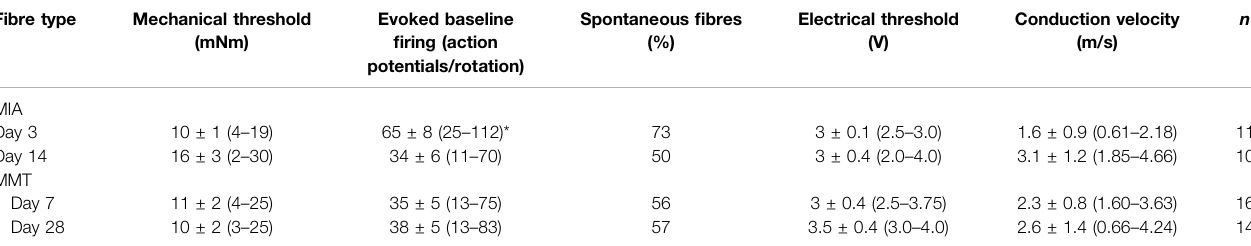
TABLE 2 | Electrophysiological characteristics of joint afferents from MIA and MMT animals. Fibres recorded from MIA and MMT animals during early and established OA were characterised based on baseline mechanical thresholds and evoked fi ring frequency, the presence spontaneous fi ring, electrical thresholds, and the calculated conduction velocity. * p < 0.05 denotes statistical signi fi cance comparing the two timepoints in each model using a Student ’ s t -test. Data presented as means ± SEM and (range). ND, not